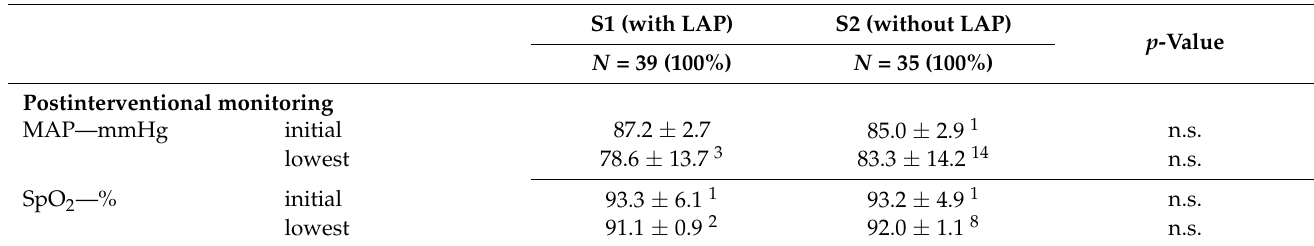
Table A2. Cont. Procedures, Sedation and Peri-interventional Monitoring *